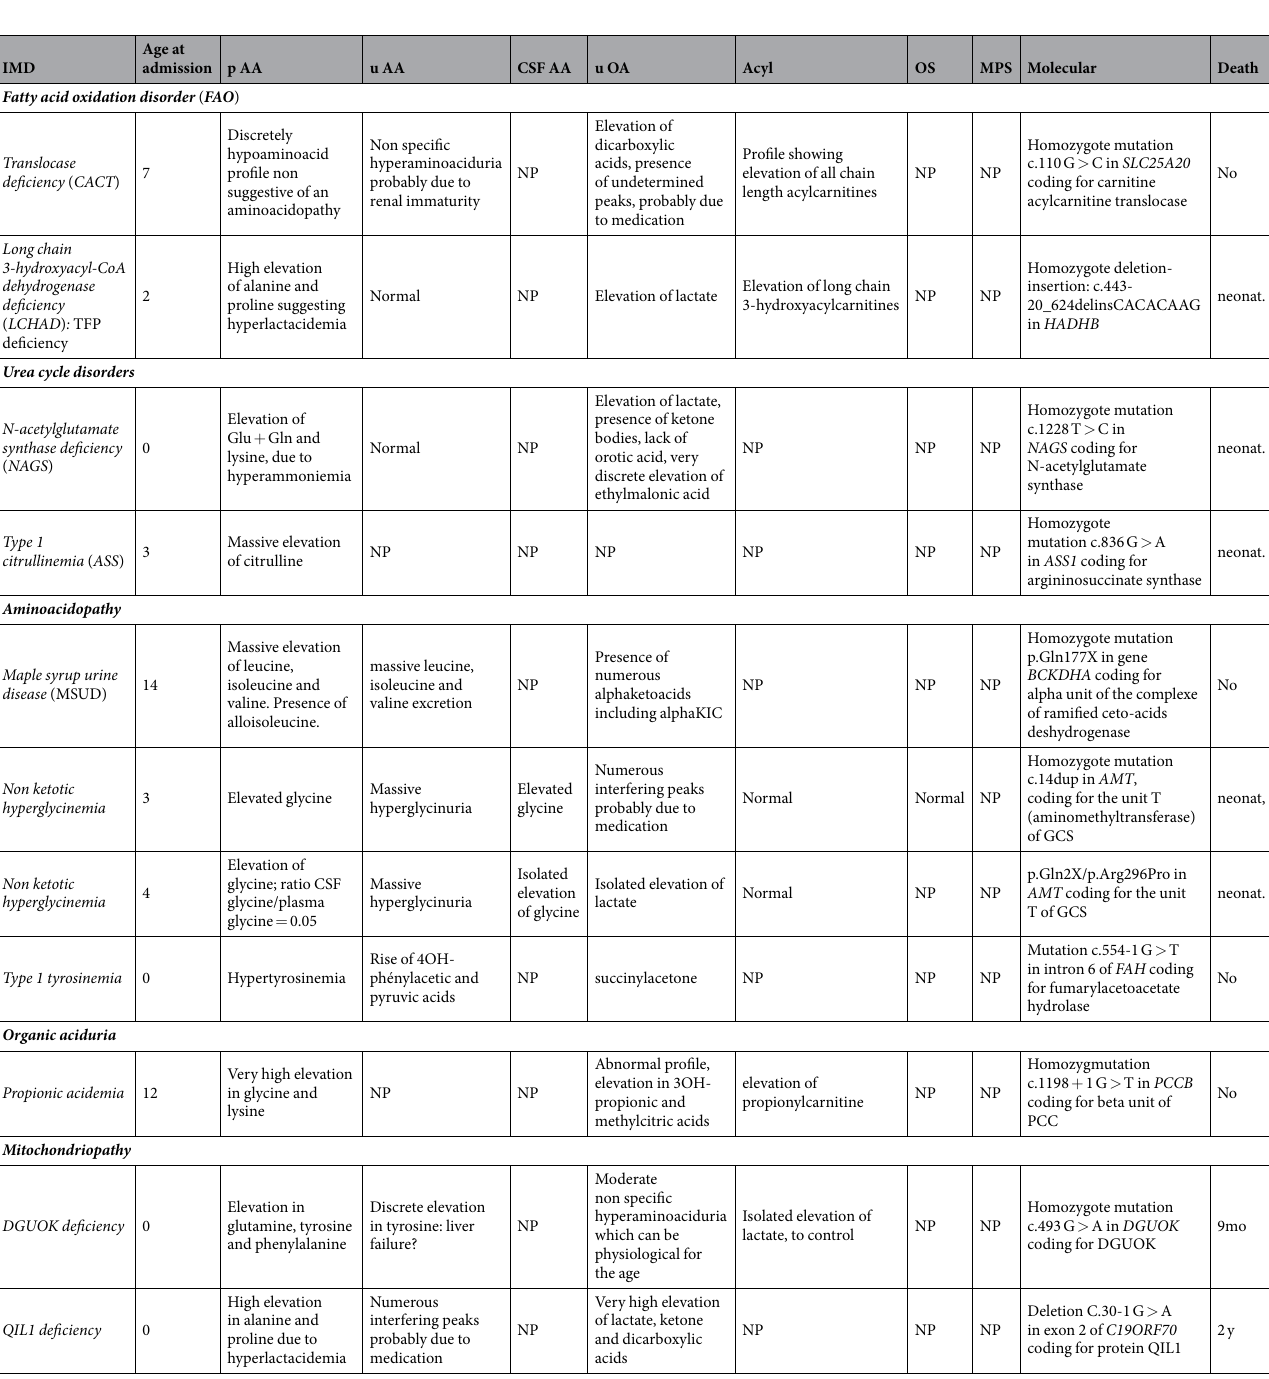
Table 9. Results of metabolic testings and molecular results of the IMD patients. Results of metabolic and molecular testings in these IMD patients. NP: not